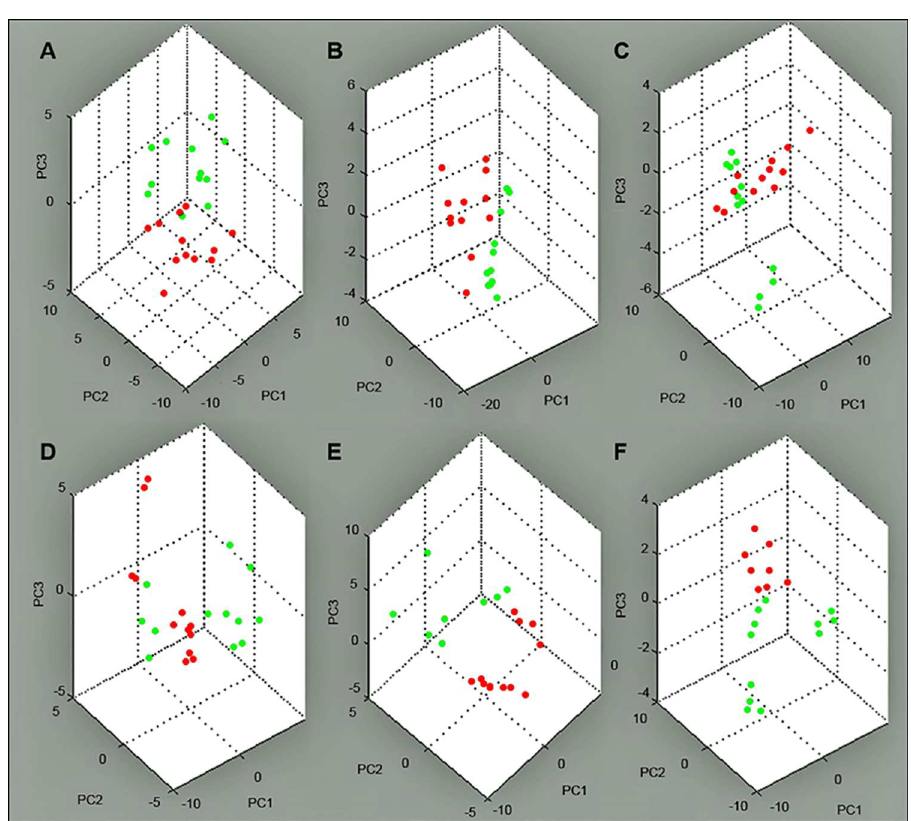
Fig 1. Representation of the principal components generated from the data set of a first cohort. (A) 0 min (red) vs . 24 h (green), (B) 24 h (red) vs . 48 h (green), (C) 48 h (red) vs . 72 h (green), (D) 72 h (red) vs . 96 h (green), (E) 96 h (red) vs . 120 h (green) * ,(F) 120 h (red) * vs . 168 h (green). For each plasma sample, 4 measurements were automatically performed. The detaileddata used for the analysiswere providedas pseudogel and stack view of the spectra in S1 Fig. * Threepigs were analyzed,except at 120 h, at which time point data were missing for 1 pig. PC,